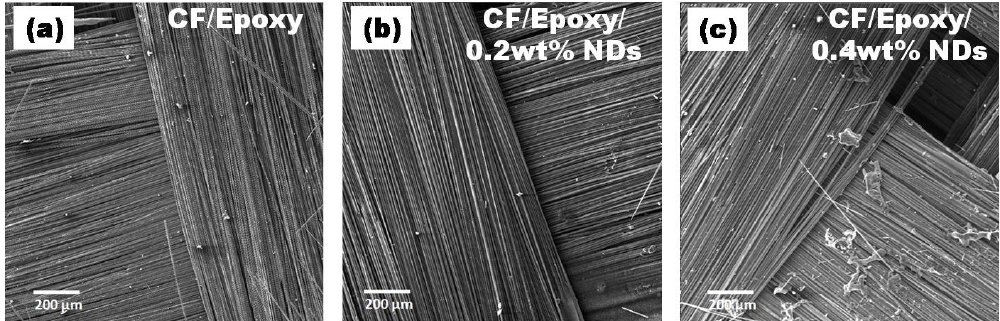
Figure 14. SEM images of CFRE-C 7 mm away from flame hitpoint where ( a ) CF/Epoxy, ( b ) CF/Epoxy/0.2 wt% NDs and ( c ) Cf/Epoxy/0.4 wt% NDs.